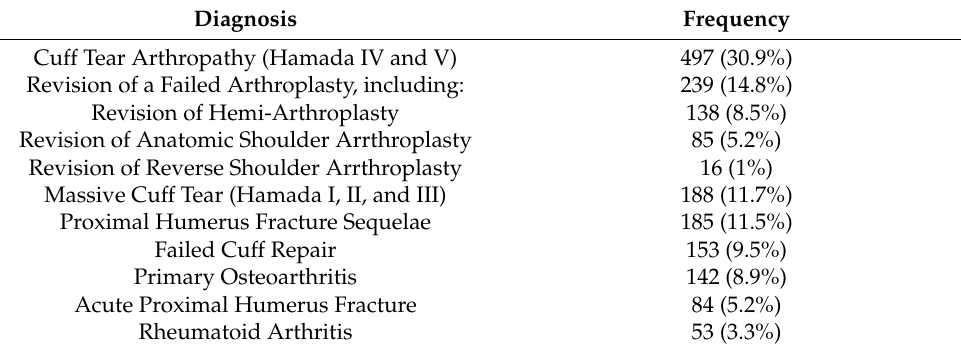
Table 1. Diagnosis for reverse shoulder